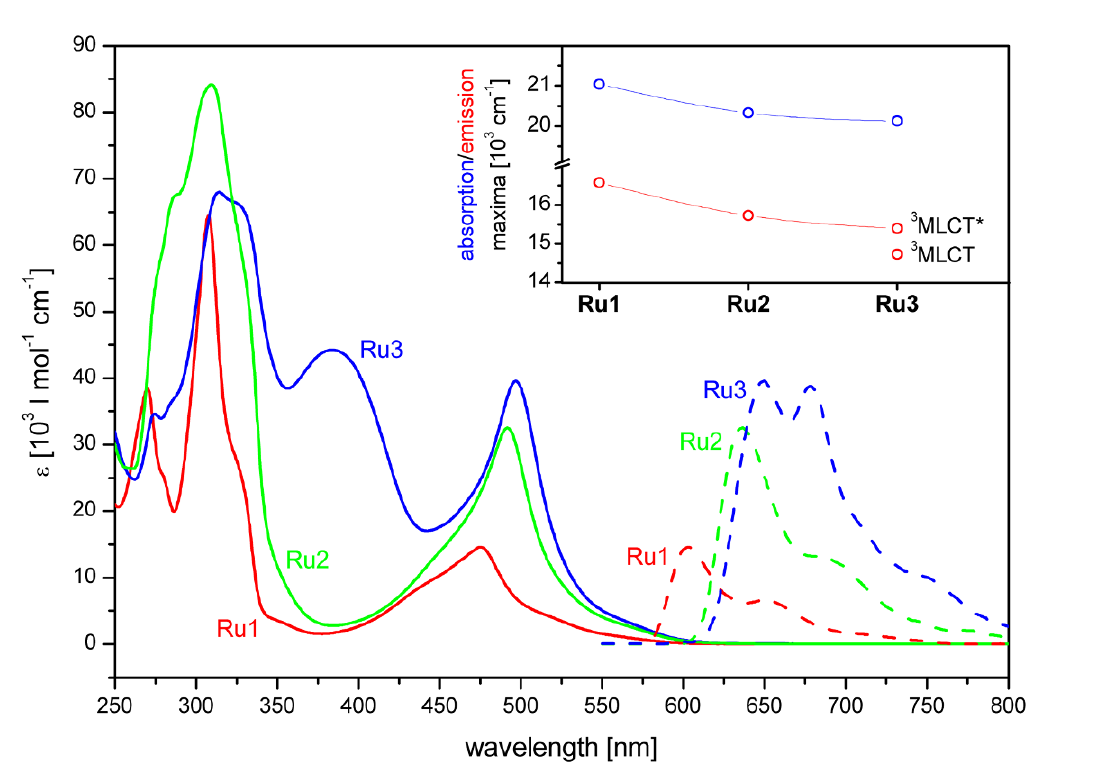
Figure 4. Room temperature absorption spectra of Ru1 (red solid line), Ru2 (green solid line) and Ru3 (blue solid line) in acetonitrile together with the emission spectra, recorded at 77 K for Ru1 (red dashed line), Ru2 (green dashed line) and Ru3 (blue dashed line). At room temperature the complexes Ru1 and Ru2 are not emissive. Furthermore, the spectral position of the 1 MLCT absorption maximum (blue) and the 3 MLCT emission maximum (red) are shown in the inset. Here, 3 MLCT’ refers to a secondary emissive MLCT excited state in Ru3 (see main text for